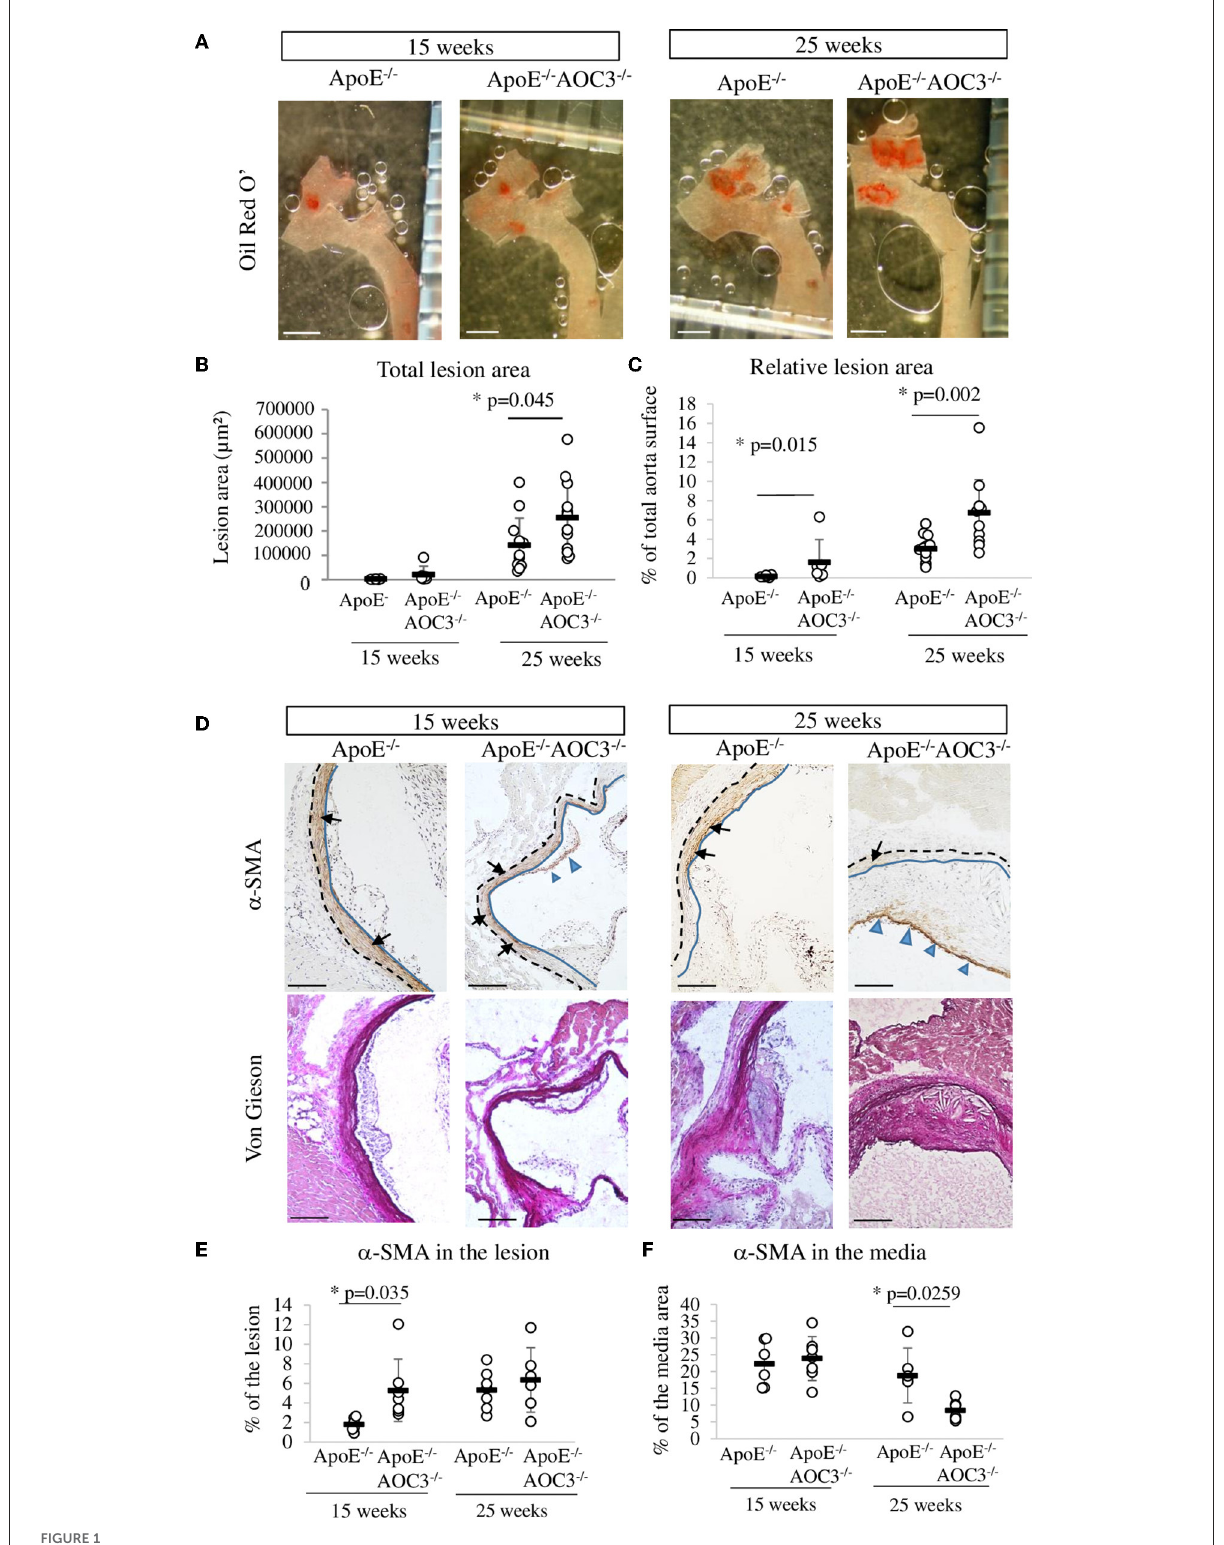
FIGURE1 Lesion surface in the thoracic aorta and α -SMA in the aortic sinus. The total lesion area was determined by measuring the red staining made by Oil Red O’ staining in the aorta open in ApoE − / − and ApoE − / − AOC3 − / − female mice at 15 and 25 weeks of age. (A) Representative pictures of